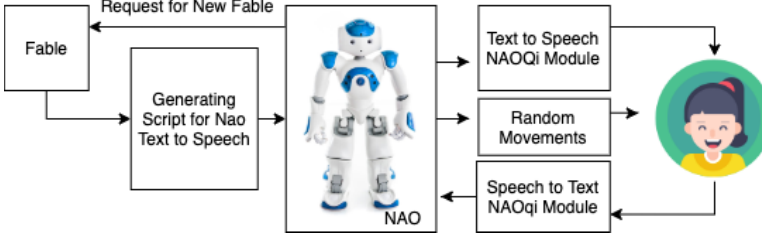
Figure 11. Setup for the experiment 1C.